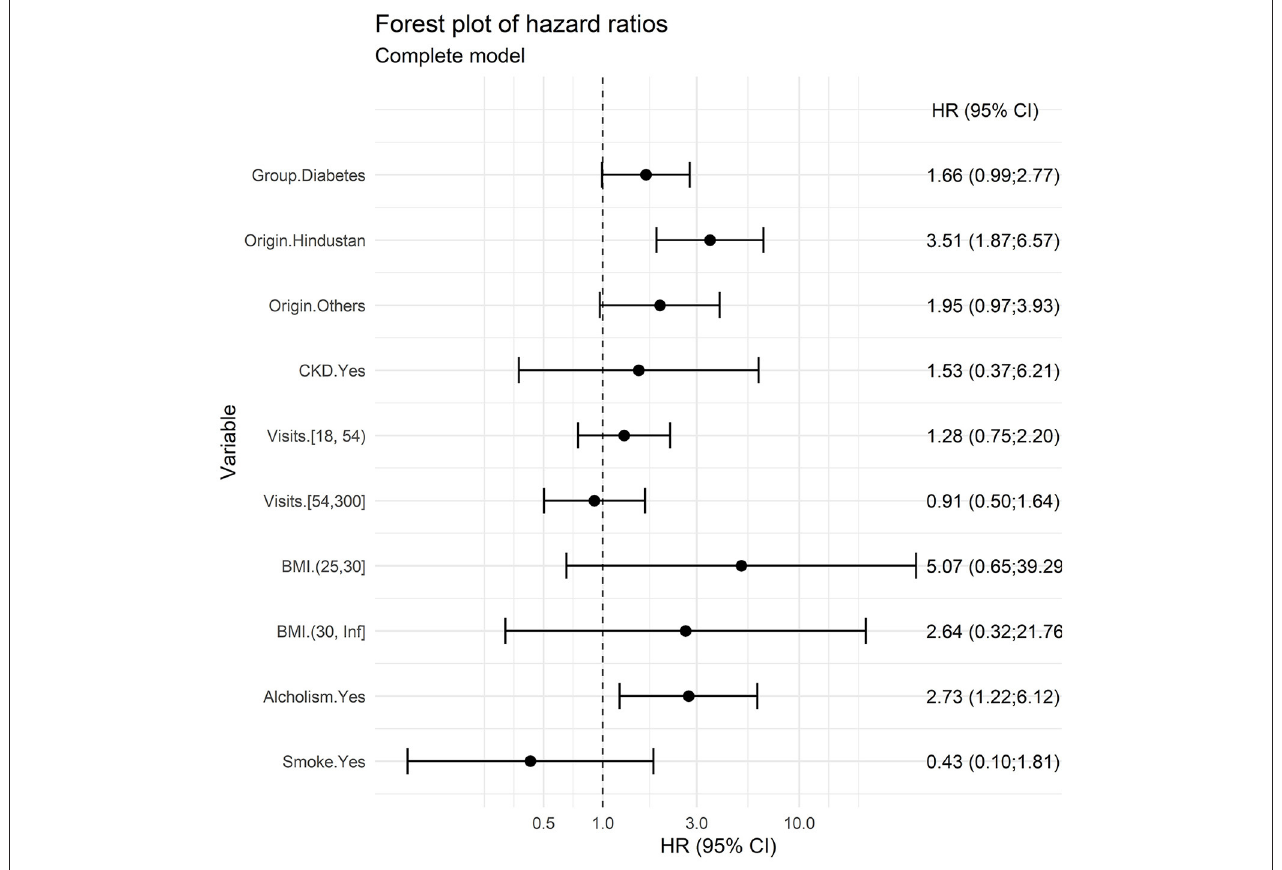
FIGURE 4 | Forest plot of HR of each TB risk factor in the multivariate